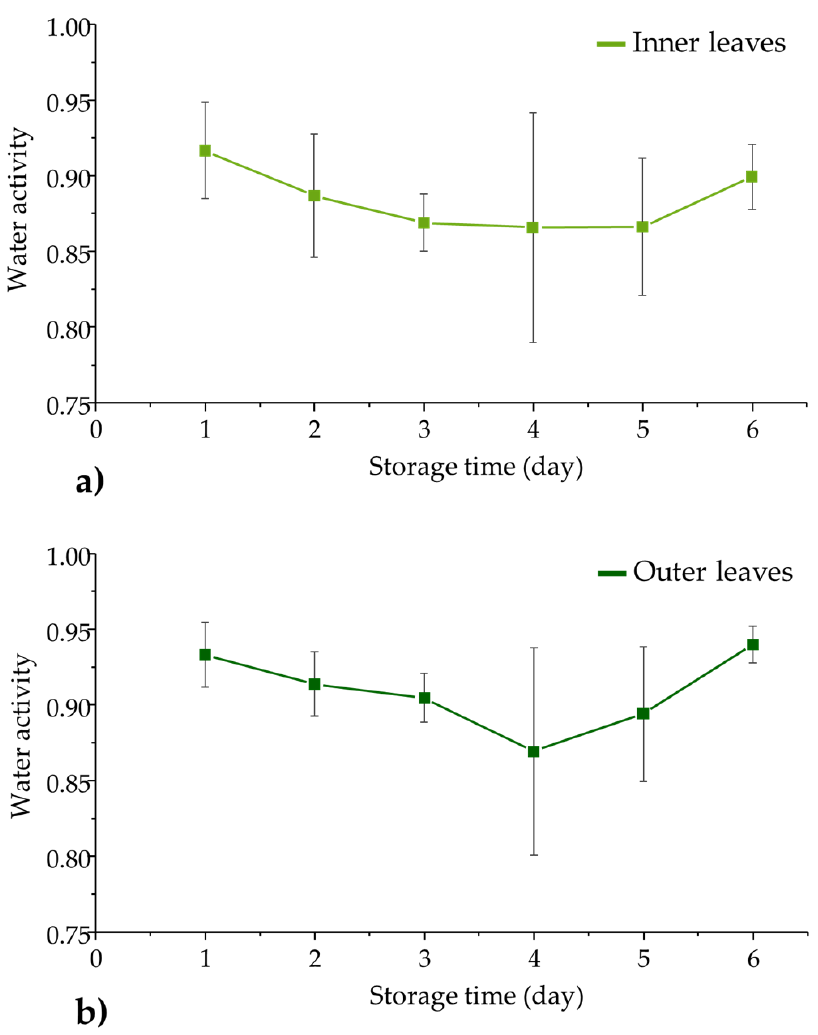
Figure 2. Temporal changes in water activity of lettuce during the six days of cold storage for ( a ) inner leaves and ( b ) outer leaves. Data are presented as mean ± standard error.